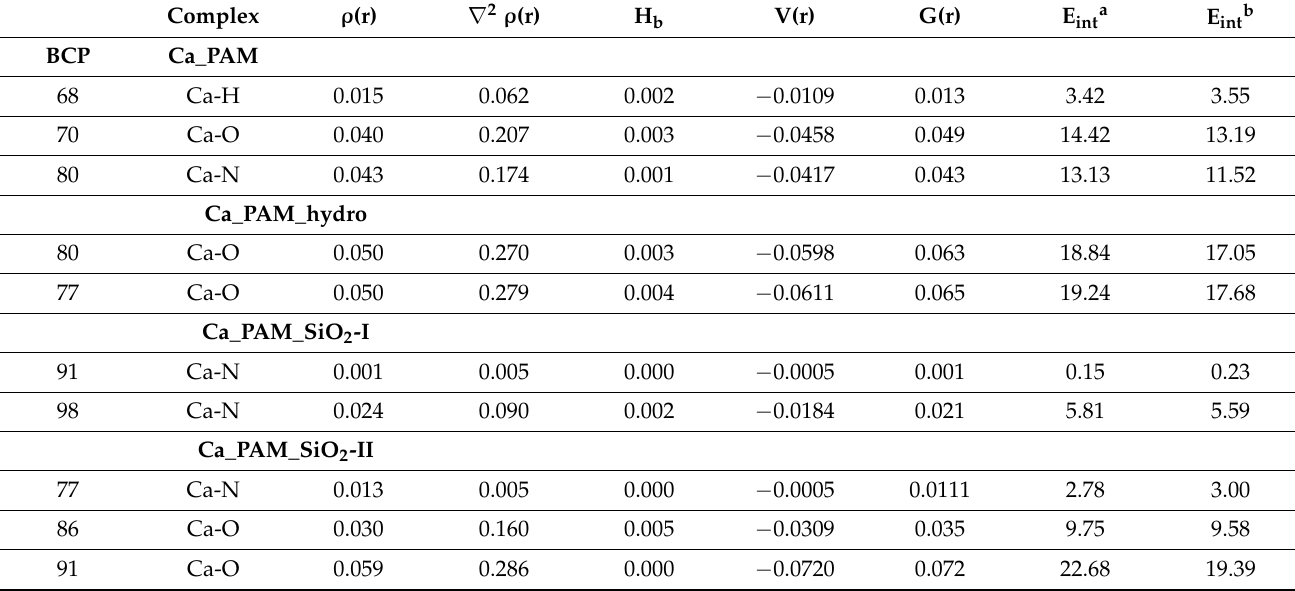
Table 1. The E int energies derived from DFT and QTAIM